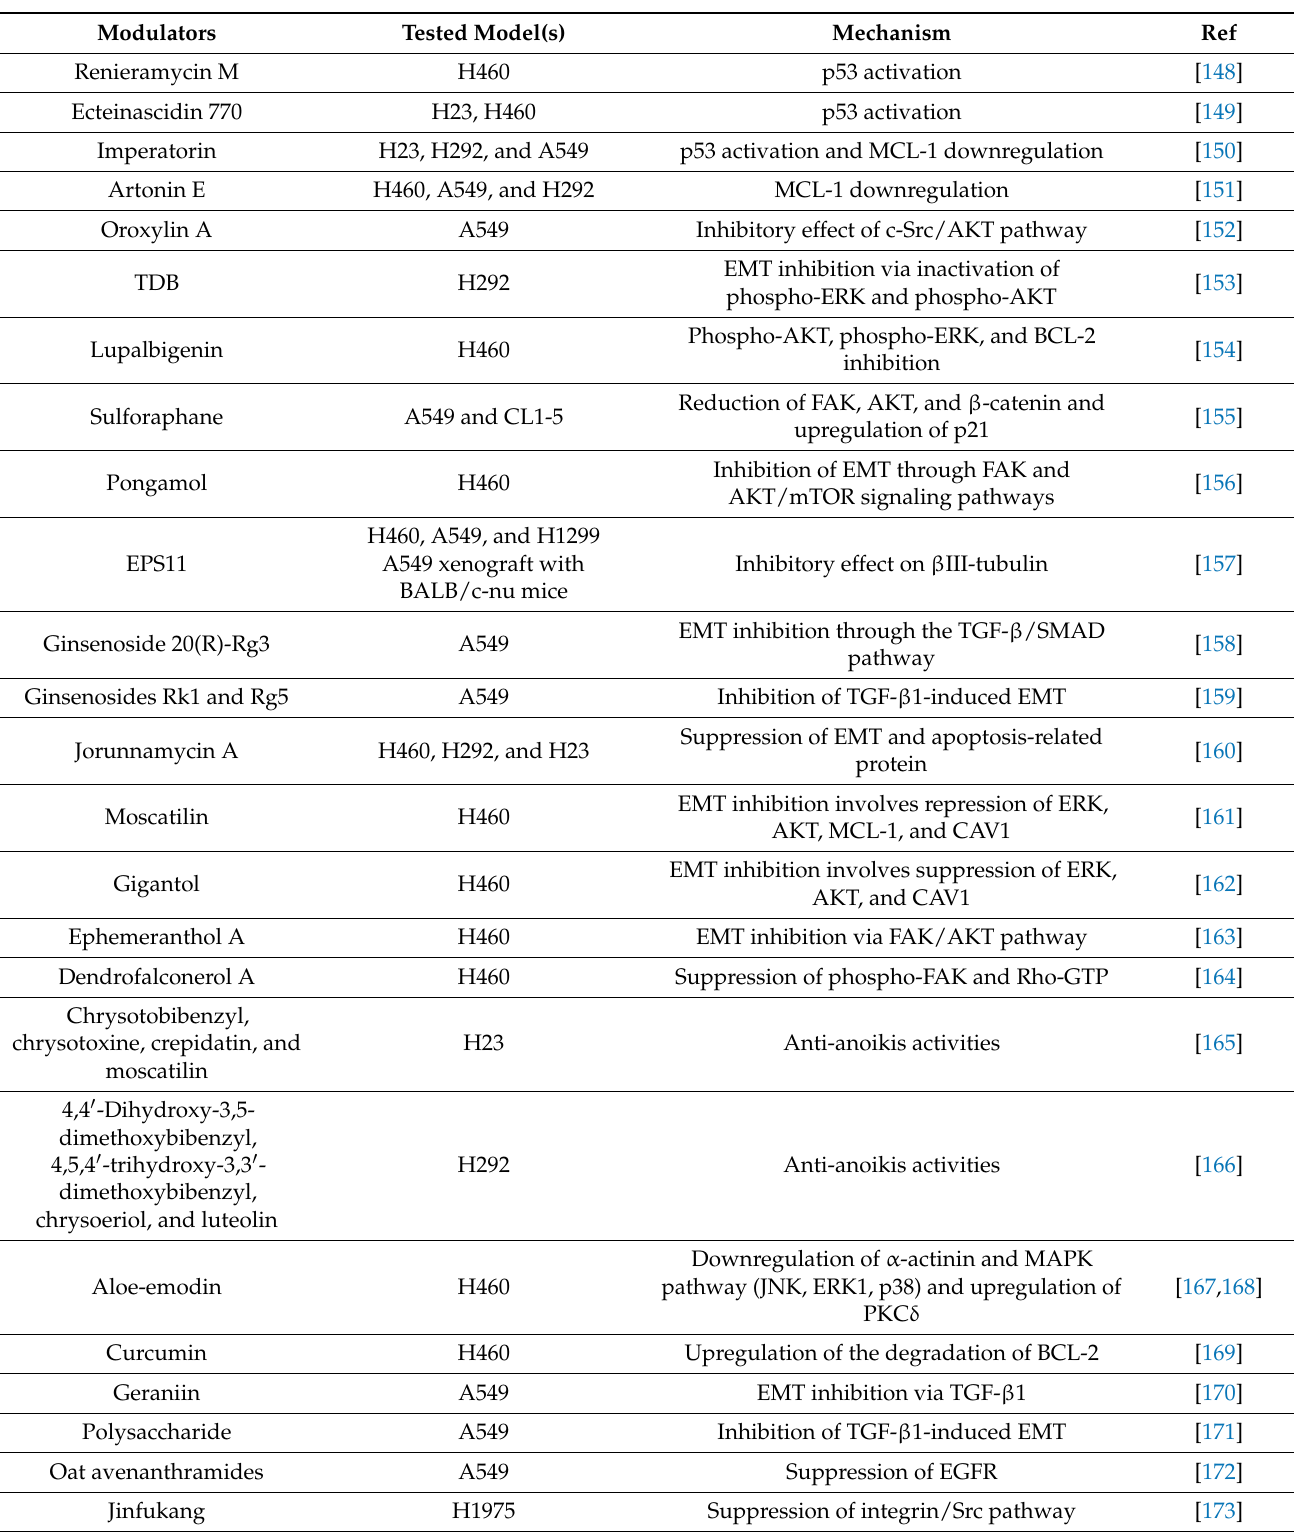
Table 2. Pharmacological modulators of anoikis in lung